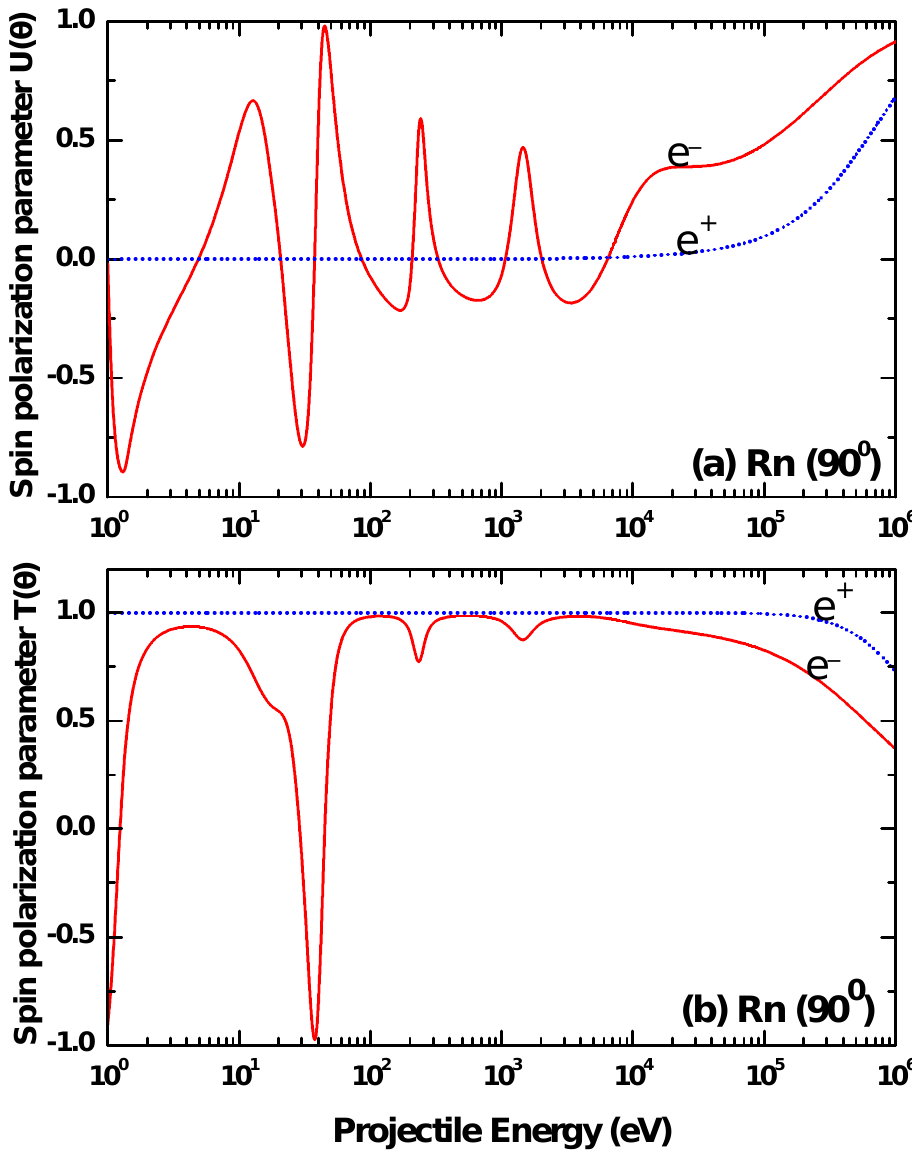
Figure 33. Comparison of ( a ) the differential cross section and ( b ) the corresponding Sherman function for the collisions of electrons and positrons from Rn 50 + ion targets at the scattering angle of 90 ◦